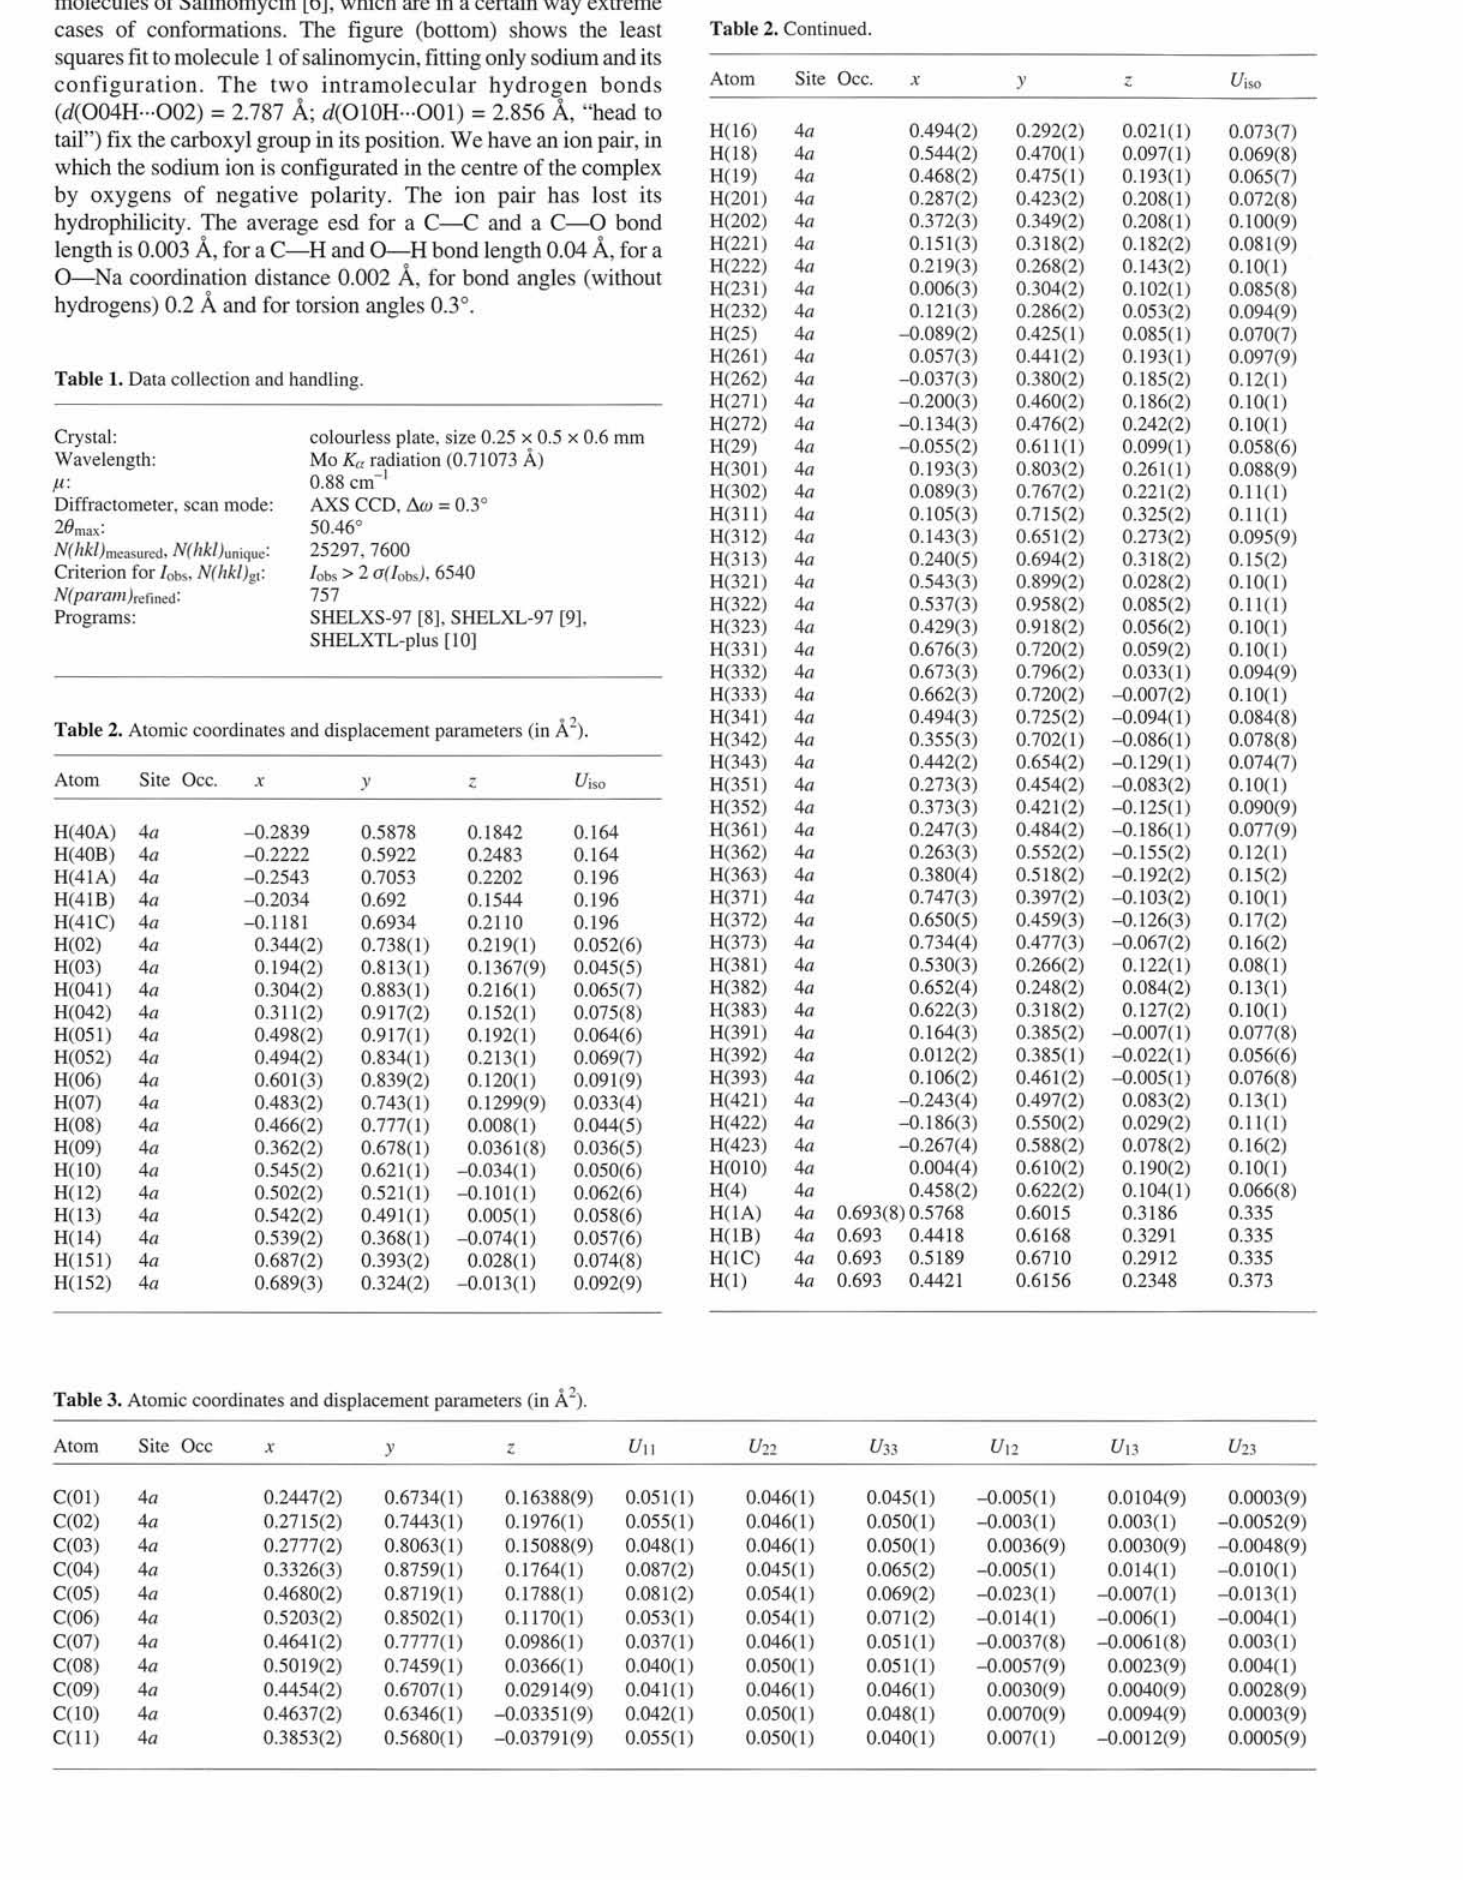
Table 1. Data collection and handling.